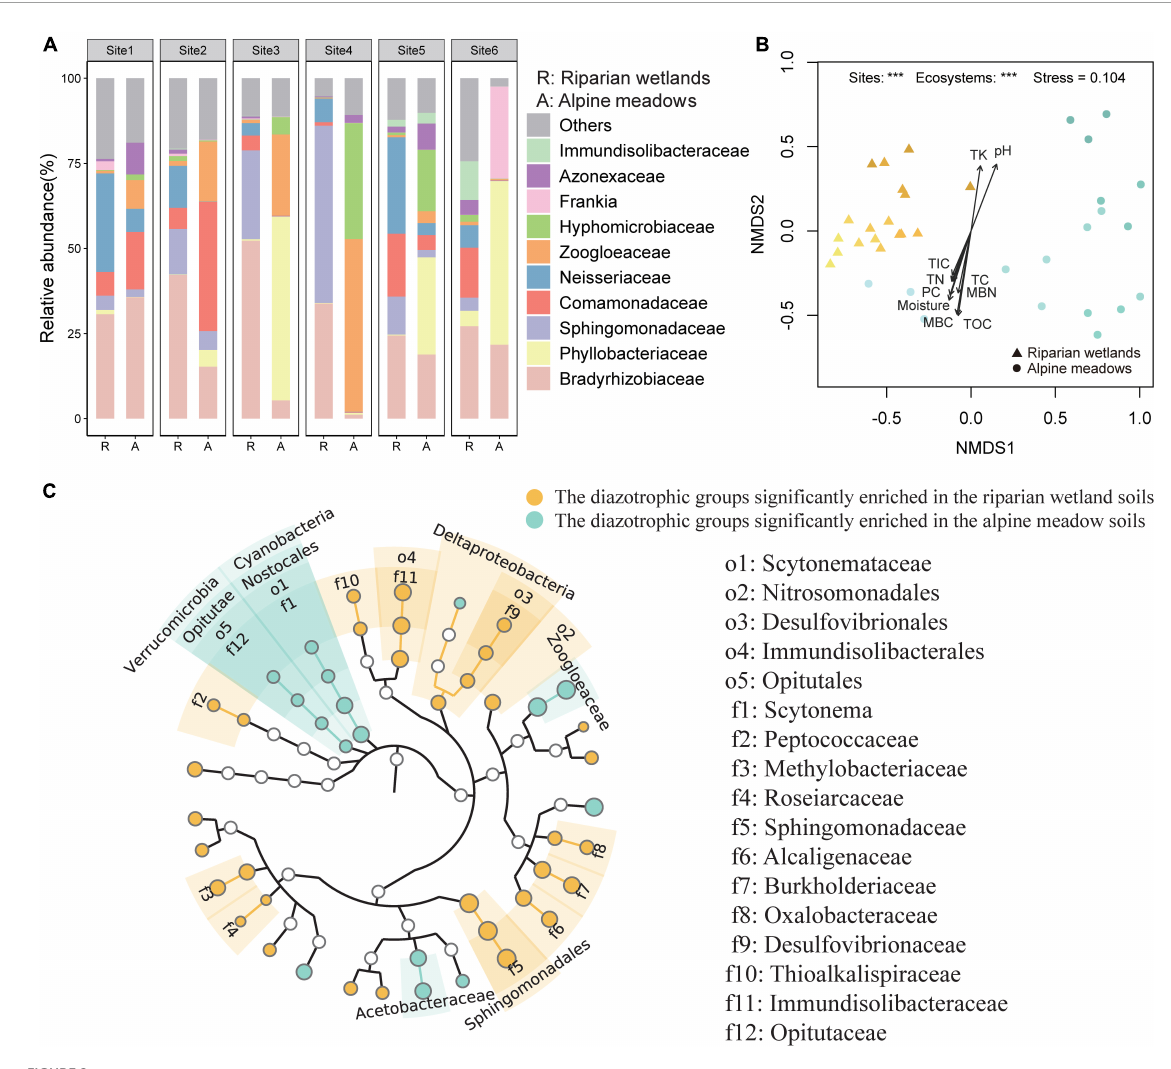
FIGURE2 The differences in the soil diazotrophic community composition between the riparian wetlands and the alpine meadows. (A) Soil diazotrophic community compositions at the family level in the riparian wetlands and the alpine meadows. (B) The NMDS ordination combined with envfit analysis of diazotrophic community structure in the riparian wetland and the alpine meadow soils. TC, soil total carbon content; TOC, soil total organic carbon content; TIC, soil total inorganic carbon content; TN, soil total nitrogen content; TK, soil total potassium content; MBC, soil microbial biomass carbon content; MBN, soil microbial biomass nitrogen content, and moisture: soil moisture content; PC, plant coverage. (C) The differences in the relative abundance of diazotrophic taxa between the riparian wetland and alpine meadow soils at the taxonomic levels from phylum to genus. The differences were revealed through the Wilcoxon test ( P < 0.05). *** P <